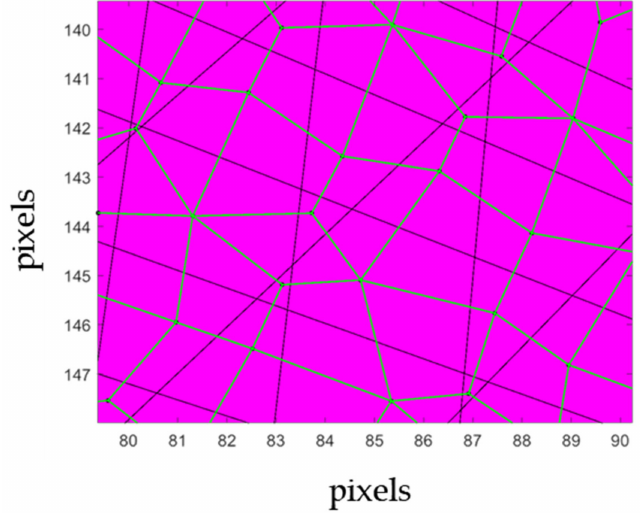
Figure 4. Portion of the